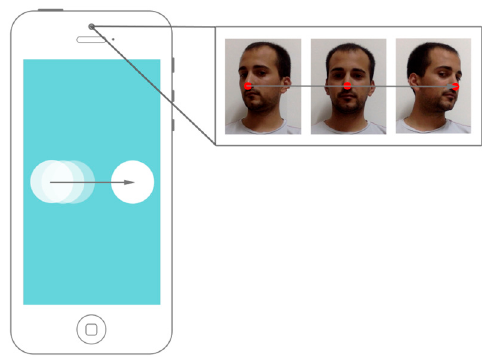
Figure 12. The head-tracker processes the user’s horizontal head gesture to translate it to an action on the device as a moving right gesture.